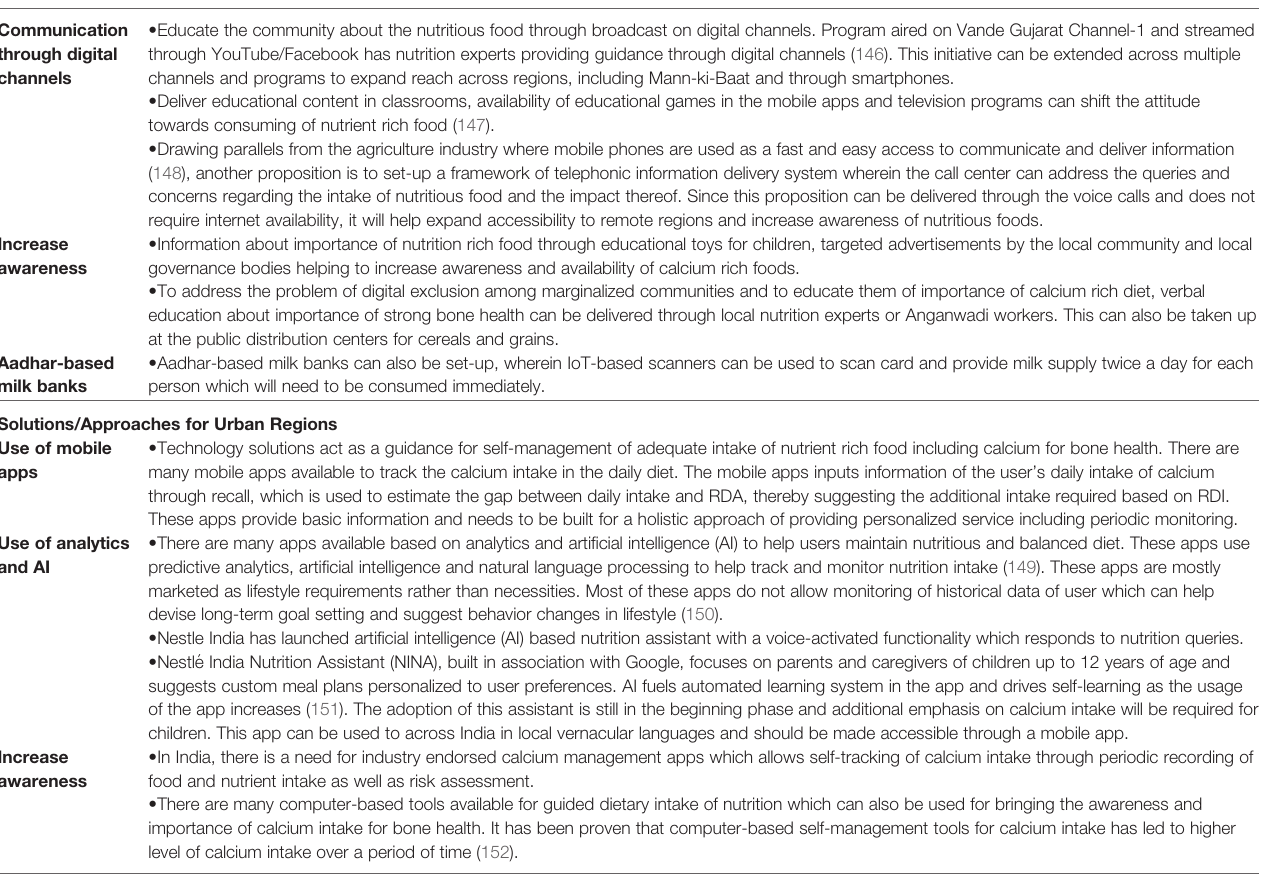
TABLE 4B | Table showing strategies to combat dietary calcium de fi ciency governmental and digital in rural and urban region. Solutions/Approaches for Rural